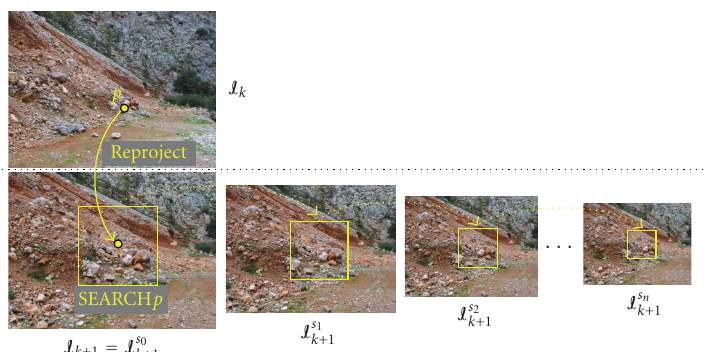
Figure 4: When seeking a correspondence for a pixel p of image I k , we reproject that pixel onto image I k +1 (using the approximate geometry of the local models and their relative pose) and then restrict our search only in a small region SEARCH p around the reprojection point. Furthermore, to take scale di ff erences into account, we search not only inside region SEARCH p of image I k +1 , but also inside the projection , which are rescaled versions of image I k +1 , that is, we search not only for a corresponding pixel, but also of SEARCH p onto the images I s k +1 for a scale estimate. In fact, all the possible pixel-scale combinations will form the candidate labels of pixel p and to choose the best one of them, we will use an MRF optimization